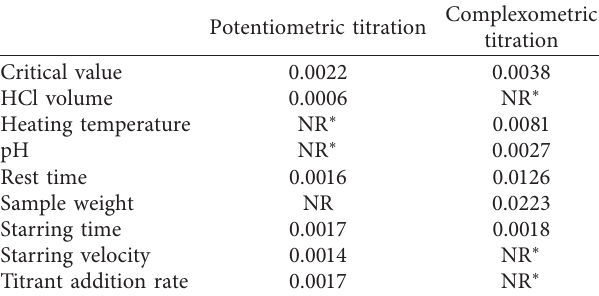
Table 3: Robustness of the method for potentiometric and com- plexometric